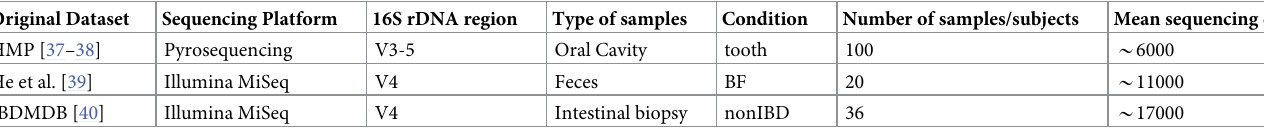
Table 2. Overview of the datasets used to estimate the parameters of condition A. Original